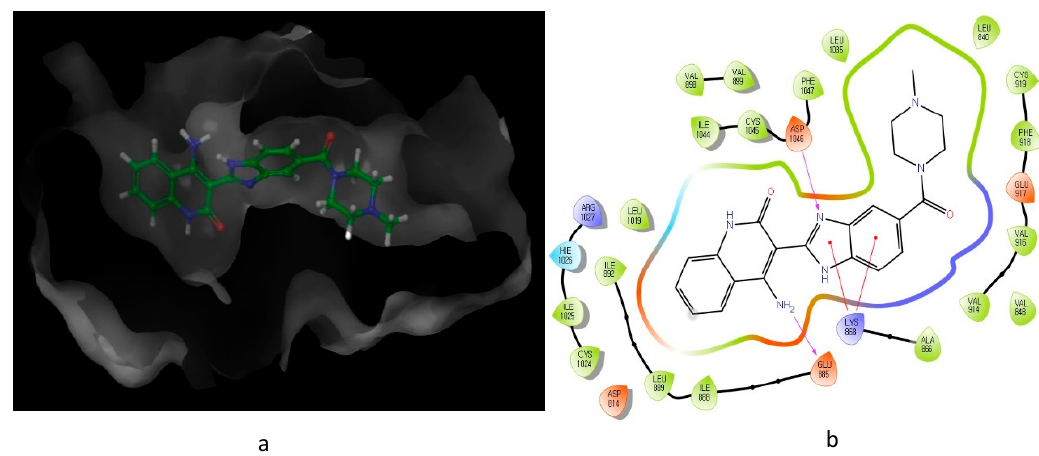
Figure 3. Predicted interaction of compound 10 (imidazole-scaffold) with active site residues of VEGFR-2. ( a ) 3D structural view of ligand inside the receptor’s active site. ( b ) Ligand interaction diagram; violet lines represent hydrogen bonds and red lines represent π –cation interactions.